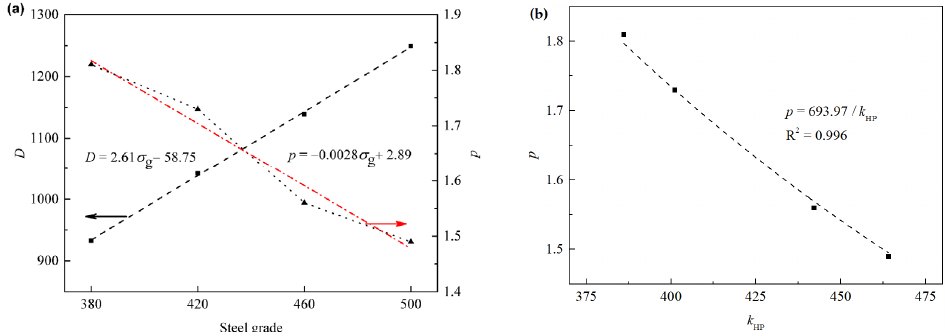
Figure 8. The variation of essential parameters in C-S model, ( a ) D and p dependence of steel grade σ g where the two arrows are pointed to two Y -axes of D and p , respectively, and ( b ) the p dependence of the Hall-Petch coefficient k HP